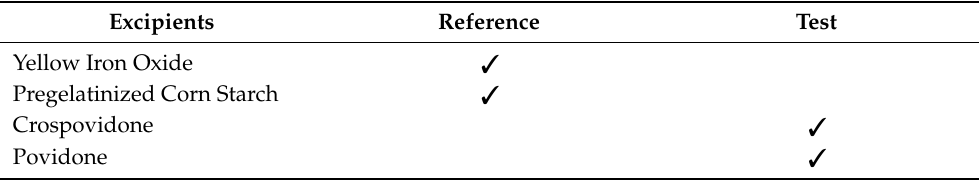
Table 1. Qualitative different composition of excipients of the reference and the test products. Excipients